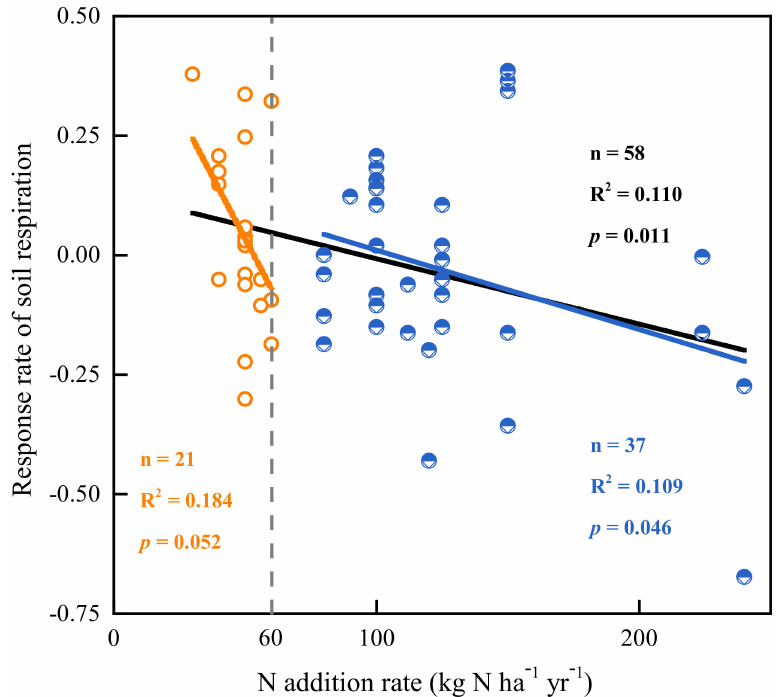
Figure 6. Linear relationship between N addition rate and response ratios of soil respiration ( RRs ) in subtropical systems of the present study and other regions of the world. Orange hollow points indicate relatively low N addition (N addition rate < 60 kg N ha − 1 year − 1 ); blue points indicate relatively high N addition (N addition rate > 60 kg N ha − 1 year − 1 ); orange line indicates linear regression between relatively low N addition rate and RRs ; blue line indicates linear regression between relatively high N addition rate and RRs ; black line indicates linear regression between N addition rate and